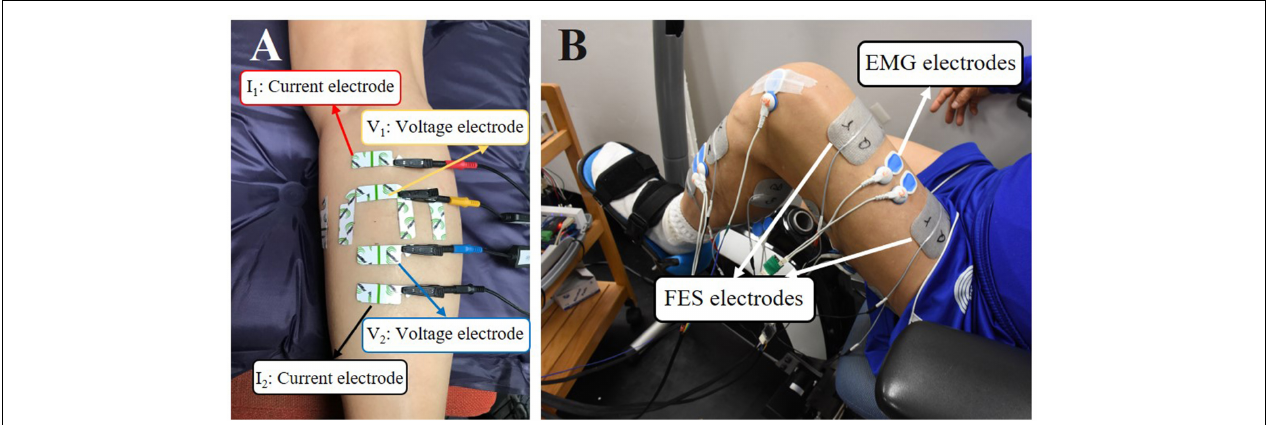
FIGURE 1 | (A) Demonstration of EIM assessment on the MG muscle. The outer two electrodes (the red and black ones) were current electrodes, and the inner two electrodes (the yellow and blue ones) were voltage electrodes. The longitudinally and transversely arranged electrodes were used, and only results from longitudinal measurement were used for statistical analysis. (B) A male subject was performing FES-assisted cycling training. The FES was triggered by muscle activation signals captured by surface electromyography (sEMG)